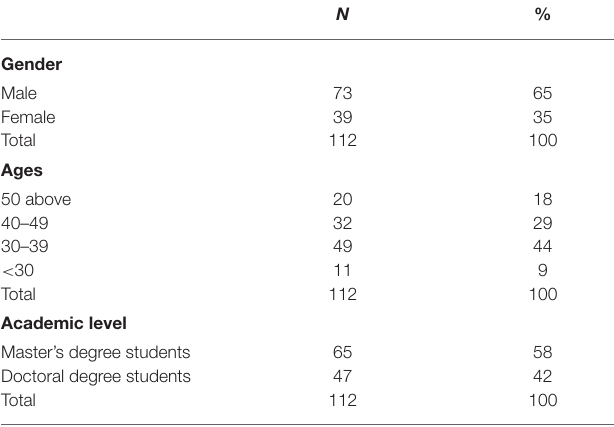
TABLE 3 | Respondents’ profile.